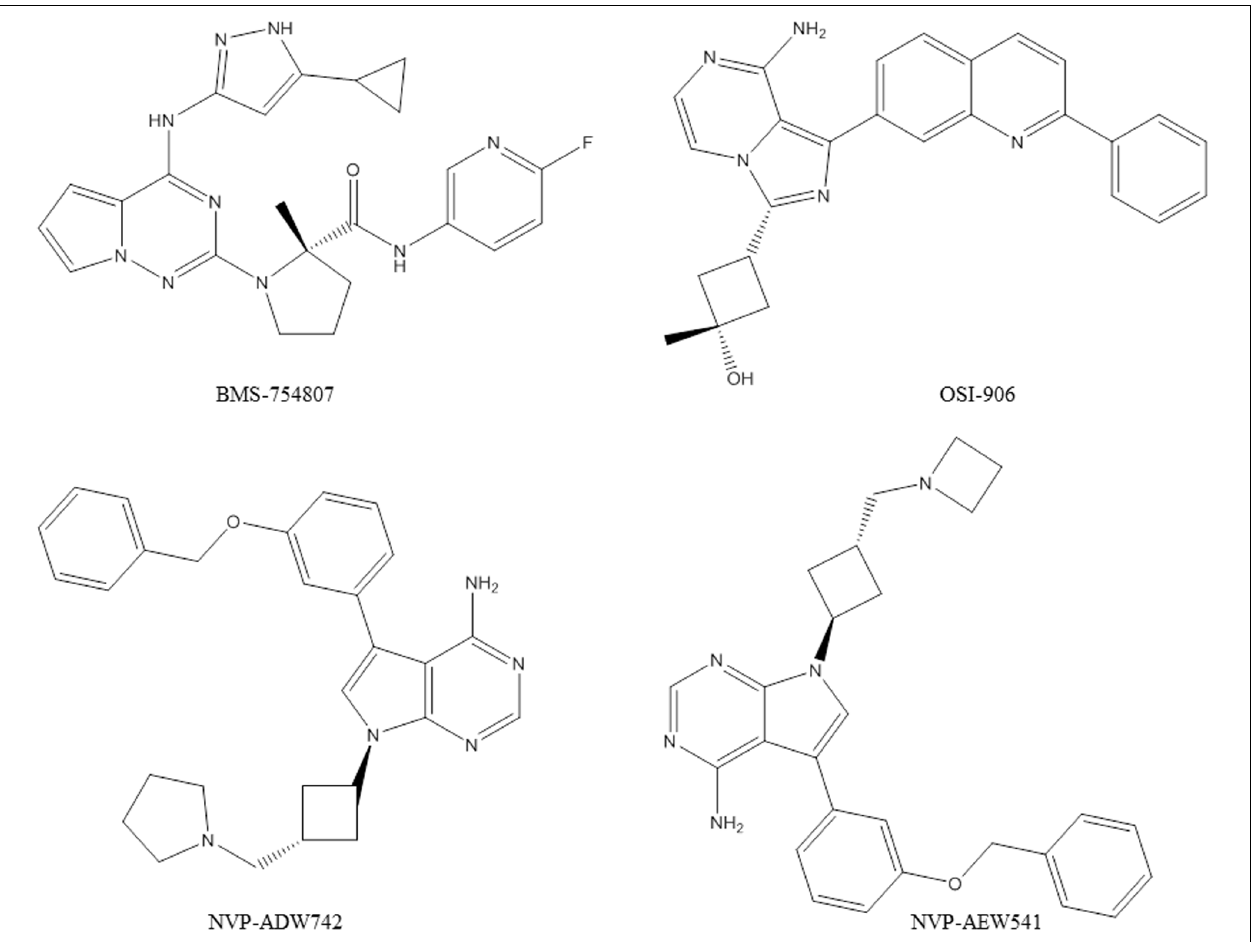
FIGURE 2 | Chemical structures of the IGF-1R tyrosine kinase inhibitors discussed in this